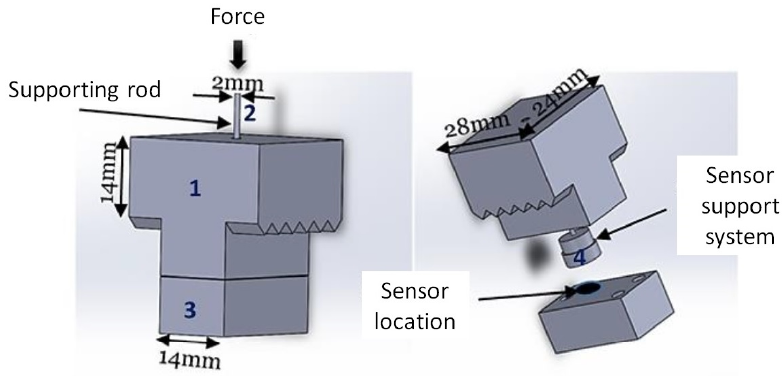
Figure 3. System to support the